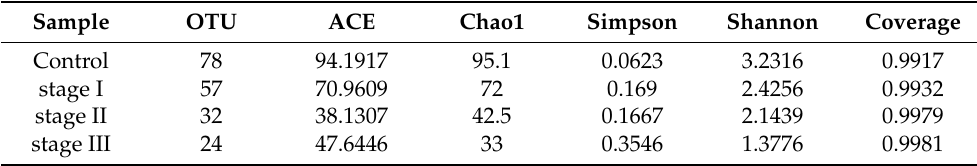
Table 1. Alpha diversity of each sludge